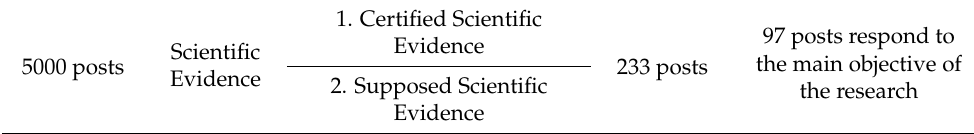
Table 3. Analysis of the